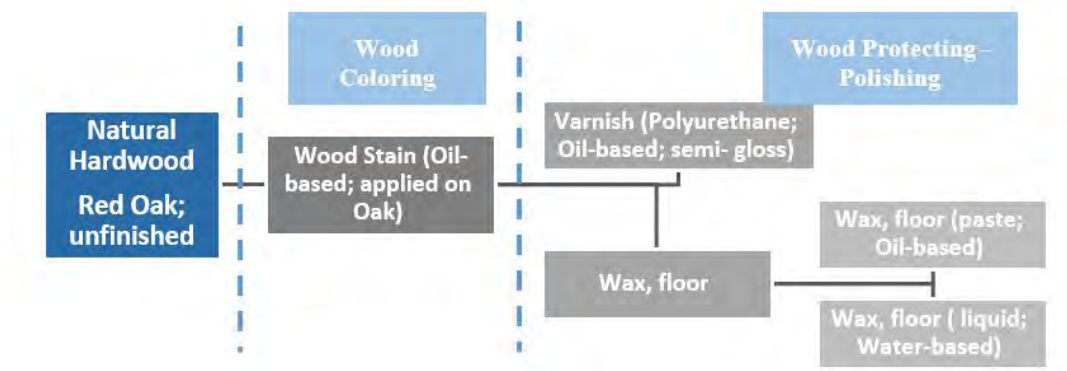
Figure 3. The wood floor finishing with different coating